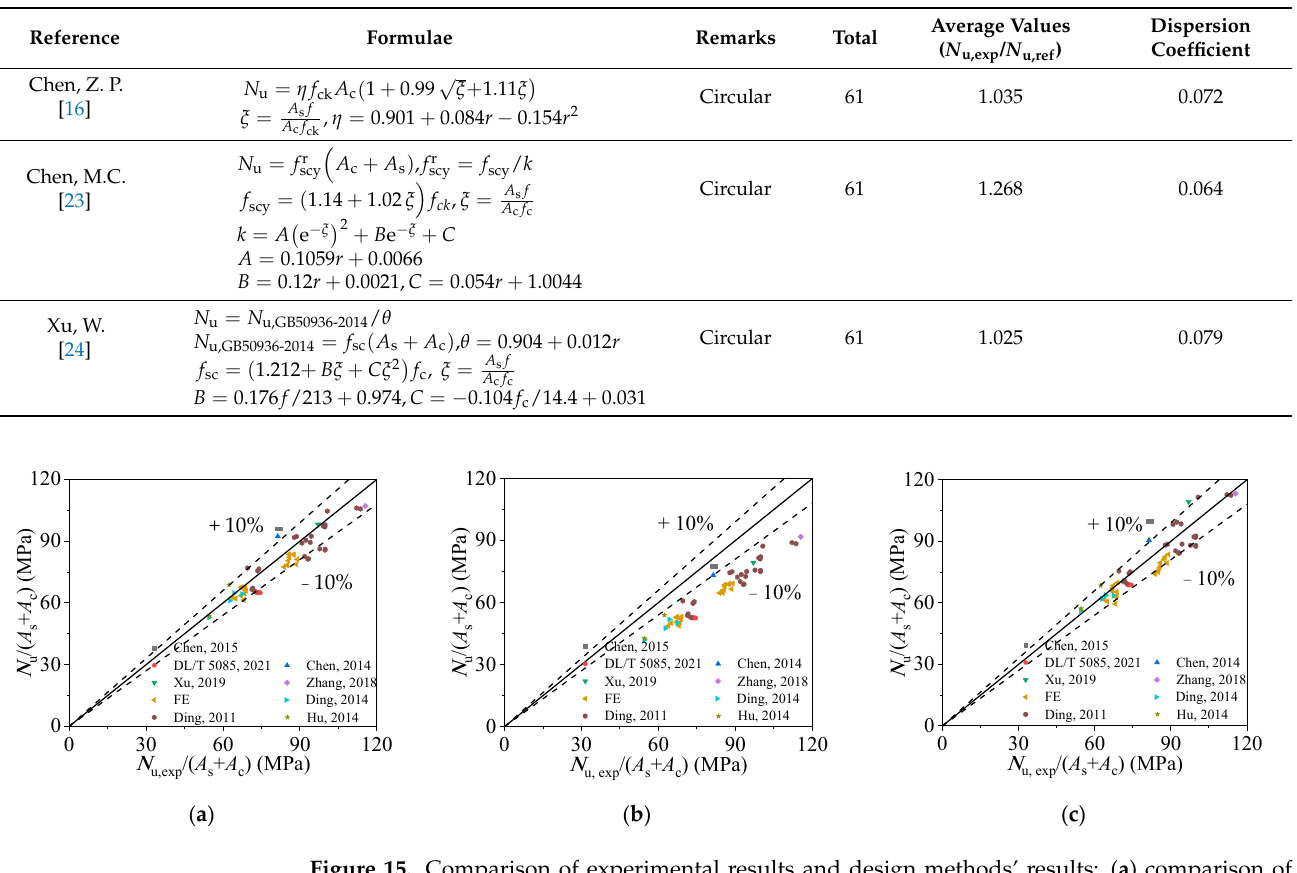
Table 6. Summary of available formulae in other scholars’ literature.